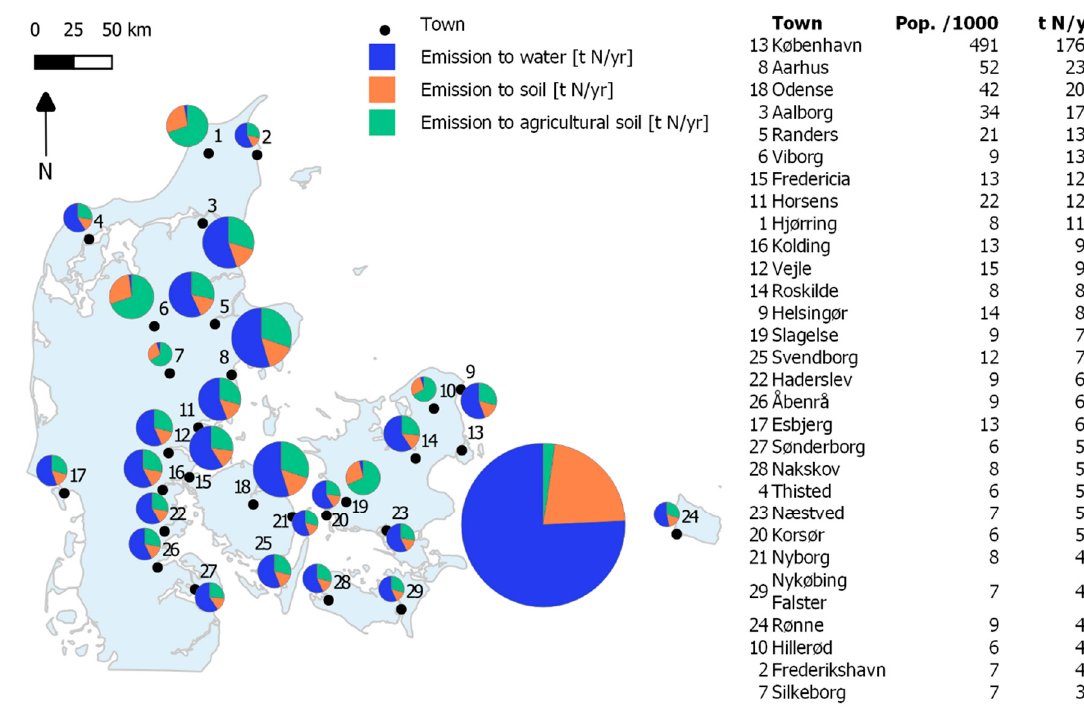
Figure 4. Danish towns with more than 5000 inhabitants in 1900. The pie chart for each city illustrates the fraction of nutrients that was emitted to water, soil or agricultural soil. The pie charts areas are sized relative to each other to illustrate the magnitude of total emissions. The population size and total nitrogen emissions from each town are listed in the table to the right. Background map from Agency for Data Supply and Efficiency [67]. Table 4. Nutrient emissions to water, landfill or soil and agricultural soil from coastal towns, inland towns, Copenhagen and slaughterhouses in 1900. Emissions to landfill or soil include spill during transport and overflows.